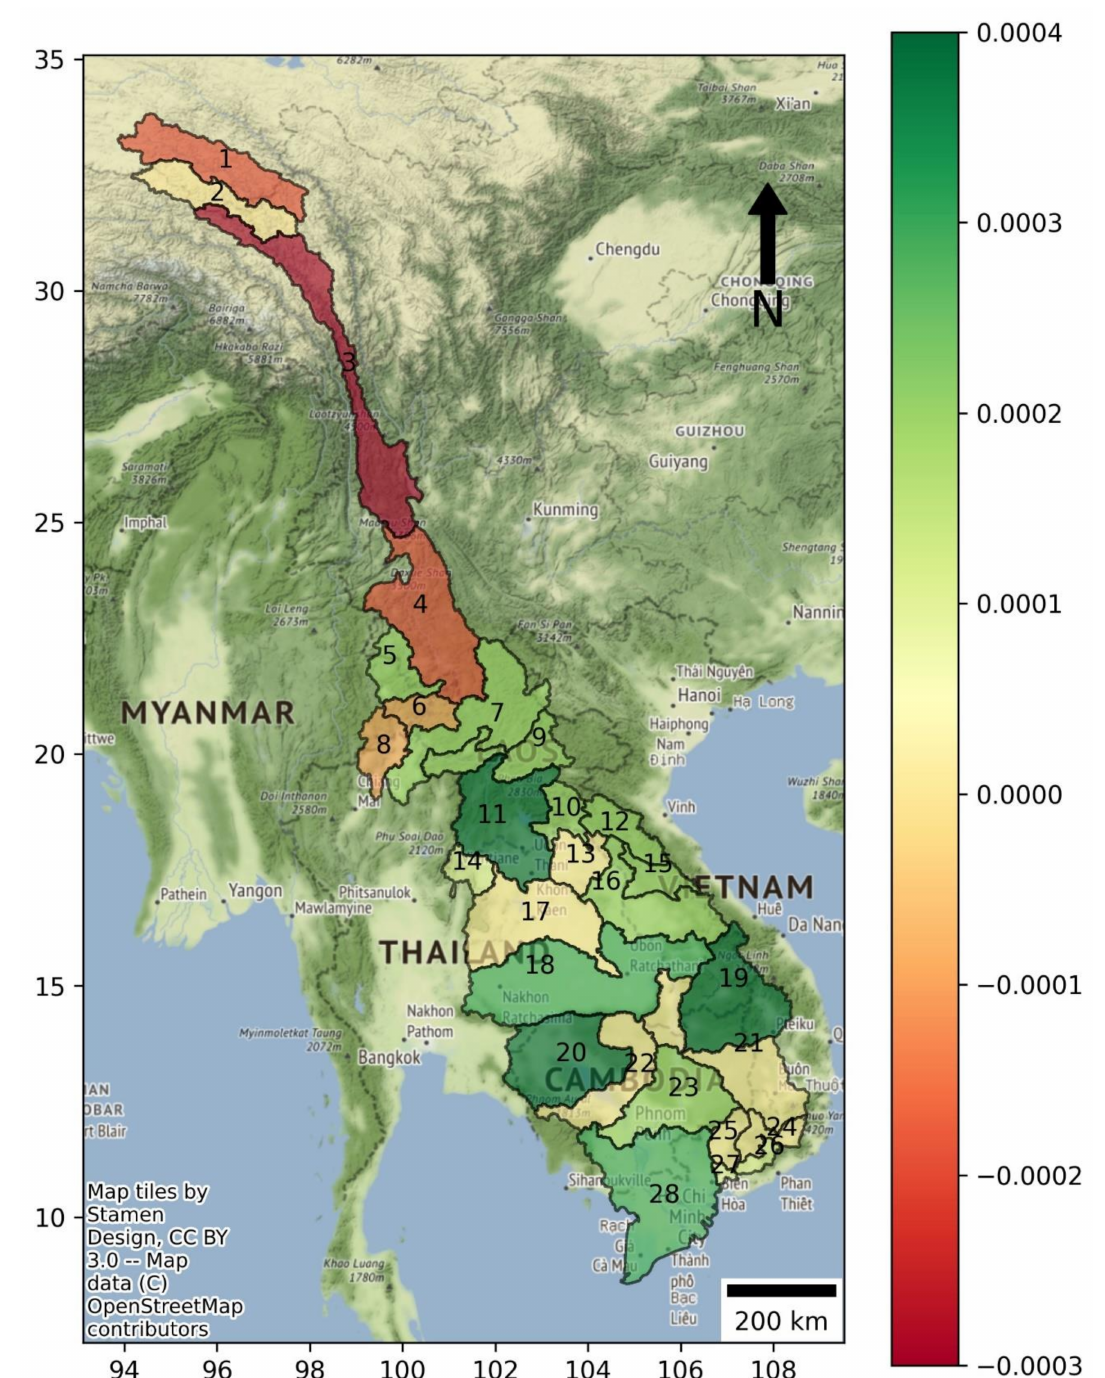
Figure 10. Slope of drought trend in the